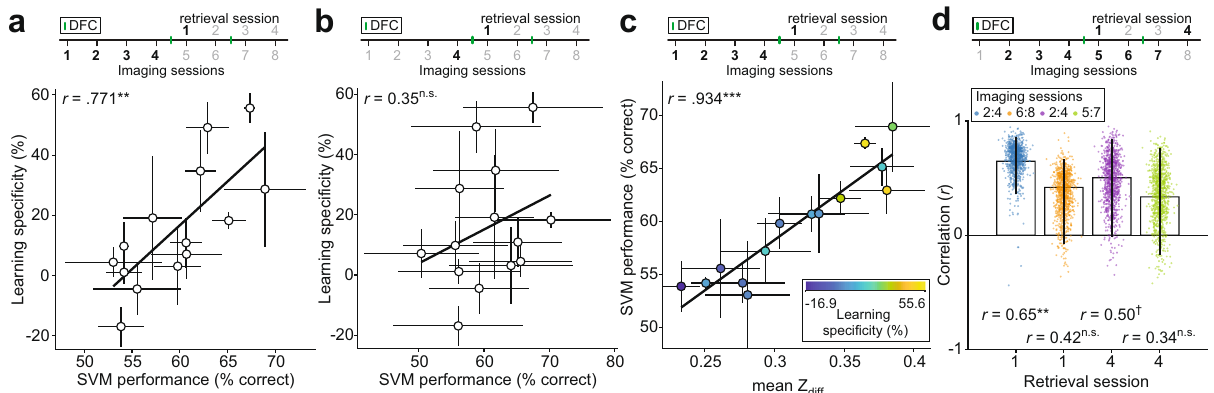
Fig. 3 Neuronal population discrimination between CS + and CS − pre-DFC predicts learning speci fi city. a Mean (±sem) SVM performance across pre- DFC sessions predicts learning speci fi city 24 h post-DFC (retrieval session 1). Statistics: two-tailed Spearman ’ s rank correlation, r (12) = 0.77, p = 0.001. b Mean (±sd) SVM performance 24 h pre-DFC does not predict learning speci fi city 24 h post-DFC. Statistics: two-tailed Spearman ’ s rank correlation, r (12) = 0.35, p = 0.247. c Mean (±sem) SVM performance pre-DFC correlates with the mean (±sem) Z diff score pre-DFC. Fill color indicates learning speci fi city from retrieval session 1. Statistics: two-tailed Spearman ’ s rank correlation, r (12) = 0.93, p = <0.0001. d Correlation (mean r ± 95% CI) between SVM performance averaged across 3 imaging sessions preceding retrieval sessions 1 (blue), and 4 (orange). Dots represent individual bootstrapped correlation values ( n = 1000). Statistics: two-tailed Spearman ’ s rank correlation: [Imaging session 2:4, retrieval session 1] r (12) = 0.65, p = 0.008; [6:8, 1] r (12) = 0.42, p = 0.155; [2:4, 4)] r (12) = 0.50, p = 0.073; [5:7, 4] r (12) = 0.34, p = 0.252. Black lines in a , b , and c show the best linear fi t. † p <